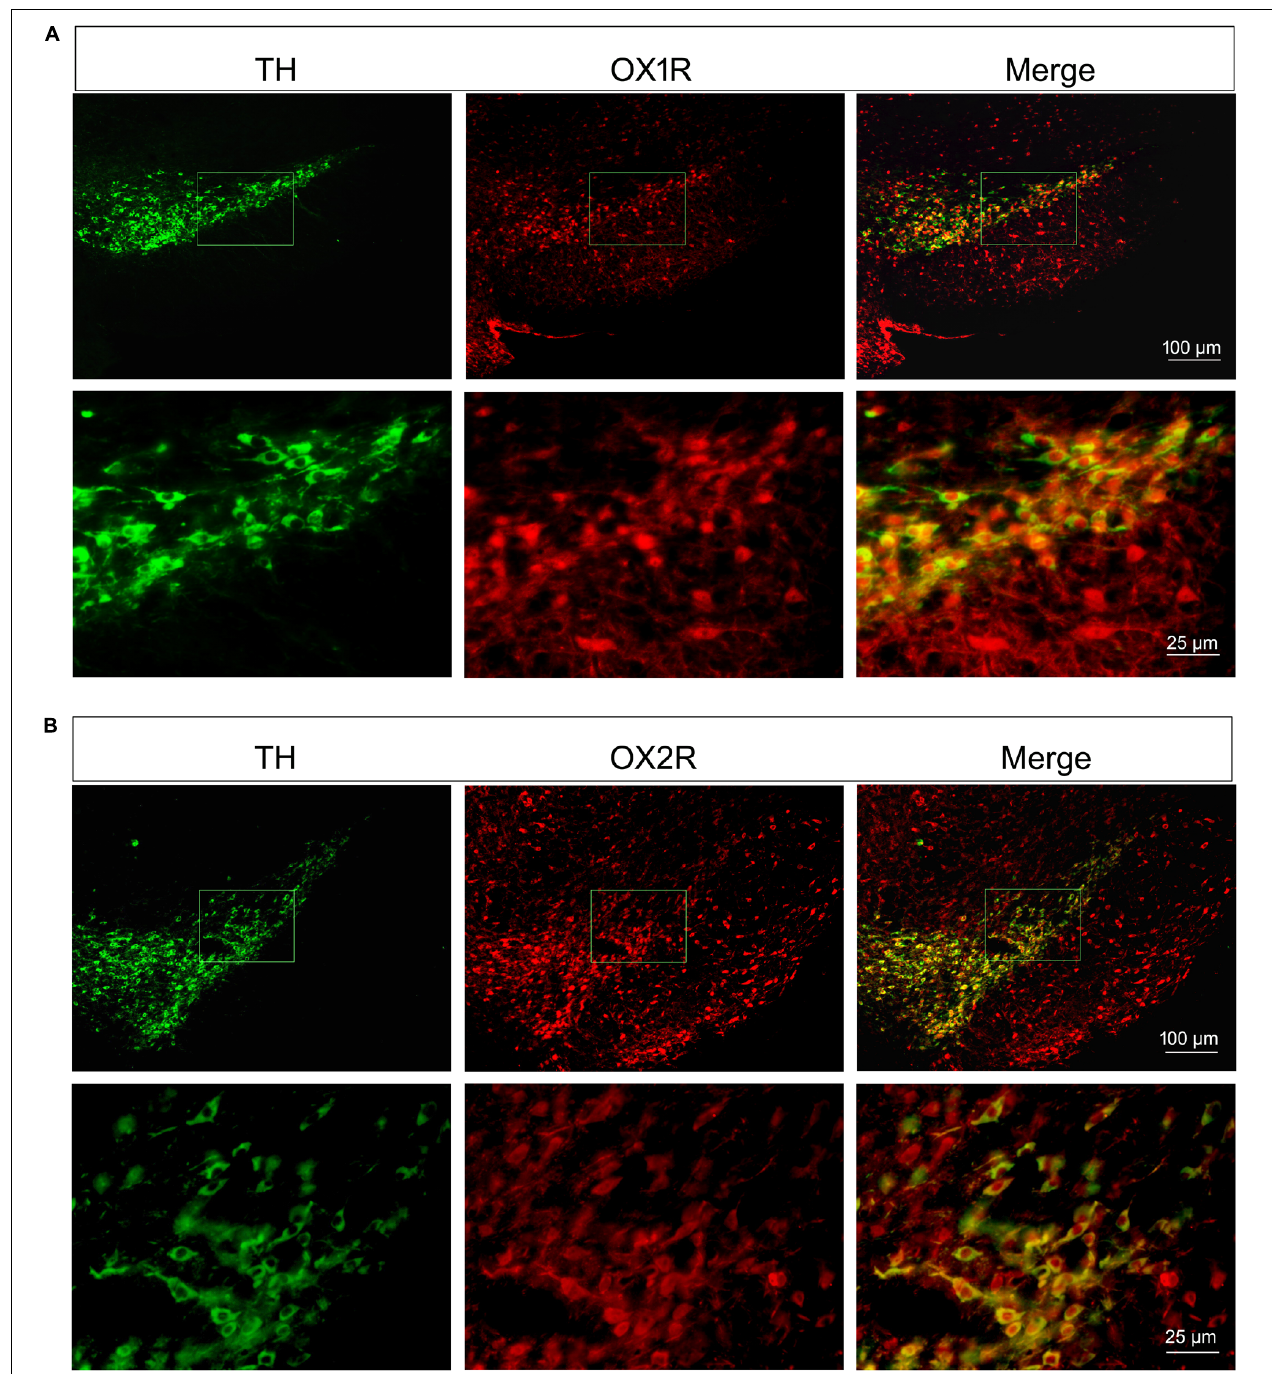
FIGURE 2 | Orexinergic receptor subtypes OX1R and OX2R co-localized with TH in the substantia nigra. Both of the OX1R (A) and OX2R (B) were expressed in the substantia nigra region and VTA. Double-labeling immunofluorescence showed the co-localization of TH (green in A,B ) and OX1R (red in A ) or OXR2 (red in B ) on the dopaminergic neurons in the